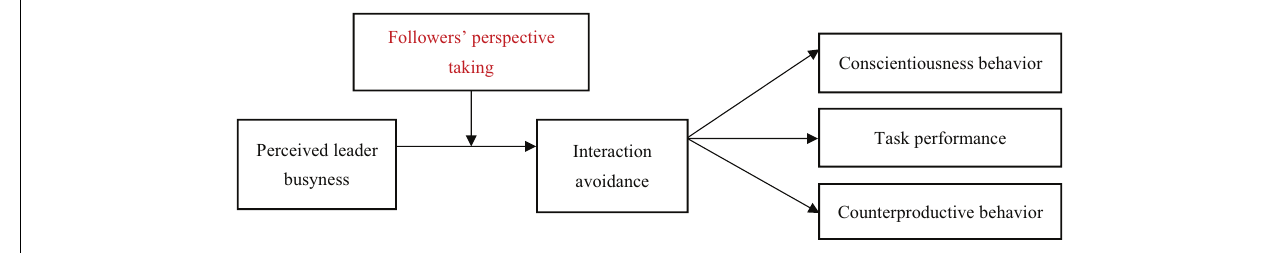
FIGURE 1 | The theoretical model of this